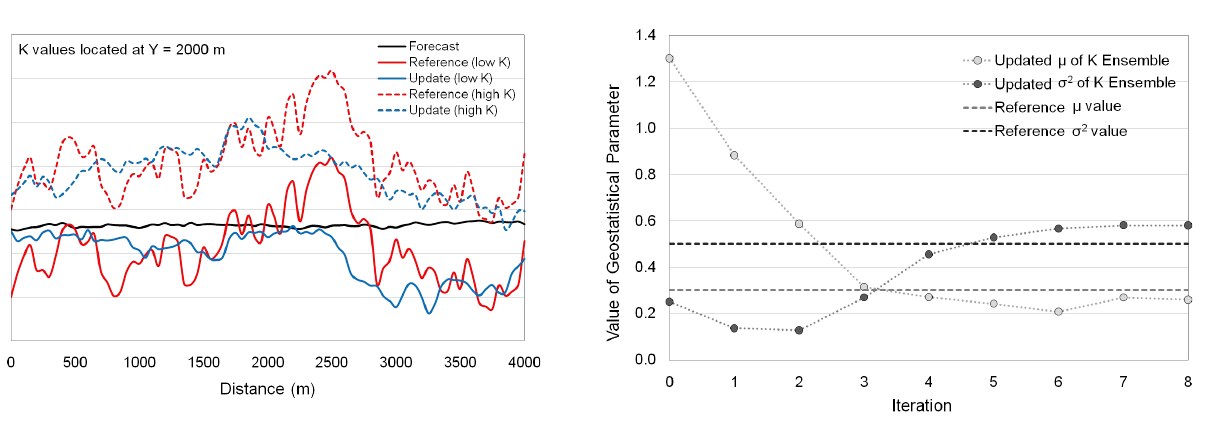
Fig. 14. Progression of the estimated GM parameters and , demon- strating the convergence of the parameter values to ∼ 0.300 log m day − 1 and 0.580 (log m day − 1 ) 2 ,